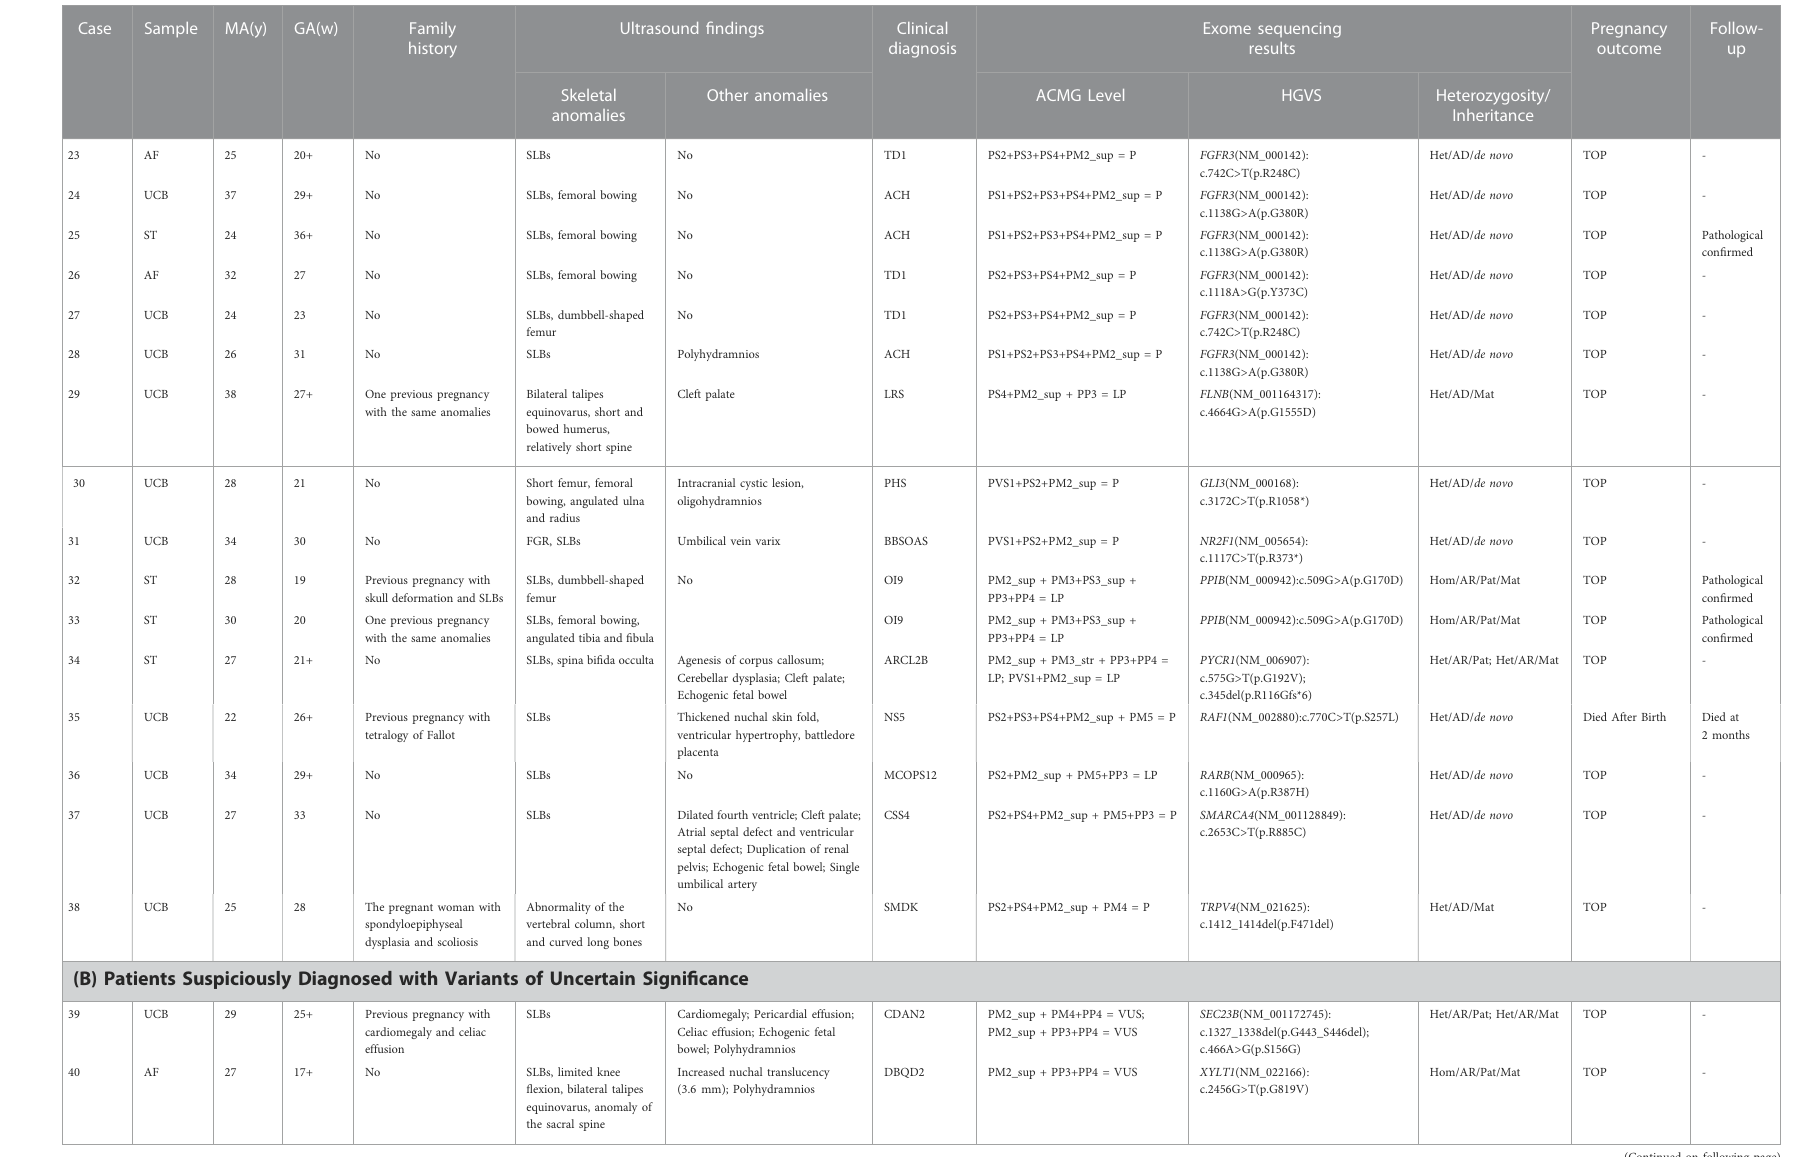
c.2653C > T(p.R885C) c.1412_1414del(p.F471del) SEC23B (NM_001172745): c.1327_1338del(p.G443_S446del); c.466A > G(p.S156G) c.2456G >